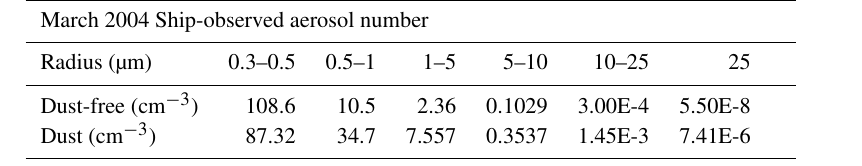
Table 2. Ship-observed aerosol number concentrations from the AEROSE campaign corresponding to the March 2004 Saharan dust outbreak.